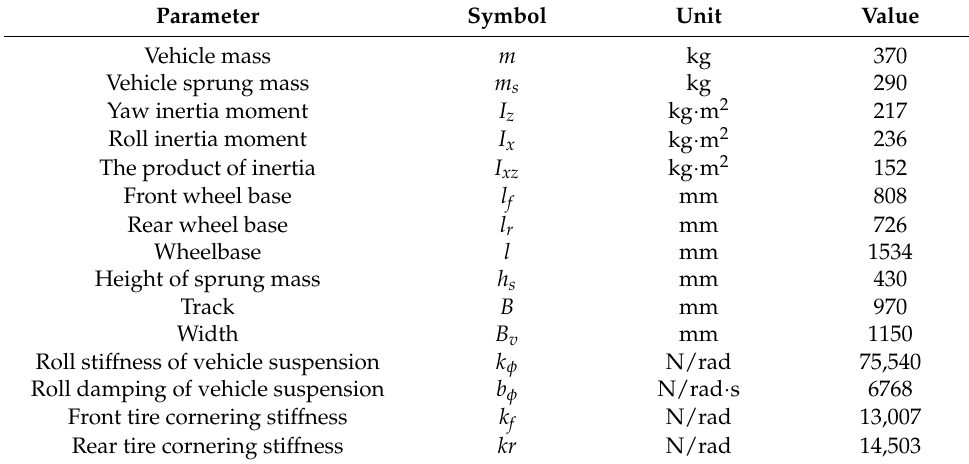
Figure 3. 4WS vehicle dynamic model. Table 1. Parameters of 4WS